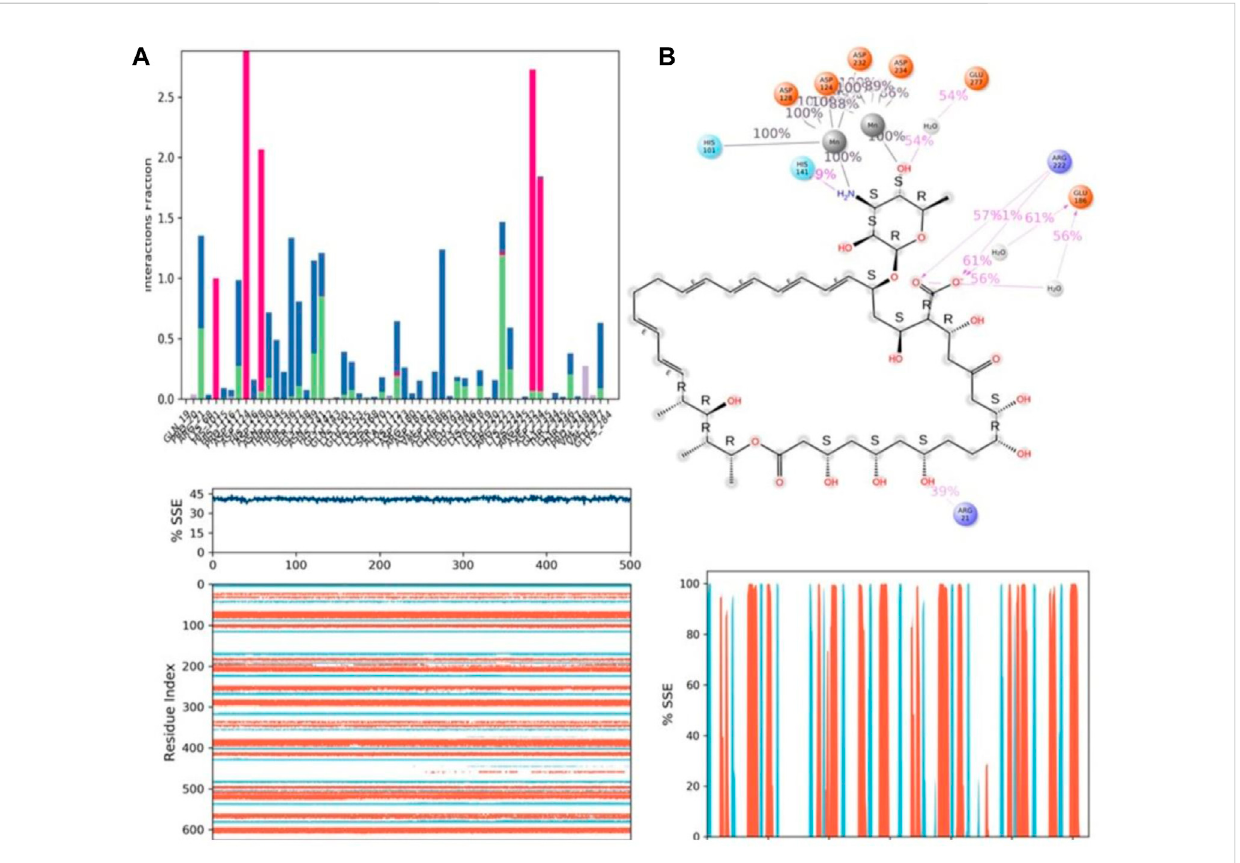
FIGURE 14 (A) Protein-ligand contact histogram (H-bonds, Hydrophobic, Ionic, Water bridges) of the non-protonated state of the ligand, ZINC000252286875boundwith3KV2recordedina500 nssimulationinterval; (B) Ligandatominteractionswiththeproteinresiduesof3KV2boundwith ZINC000252286875; (C) Secondary Structure element distribution by residue index throughout the protein structure. Red indicates alpha helices, and blue indicate beta-strands of 3KV2 bound with non-protonated